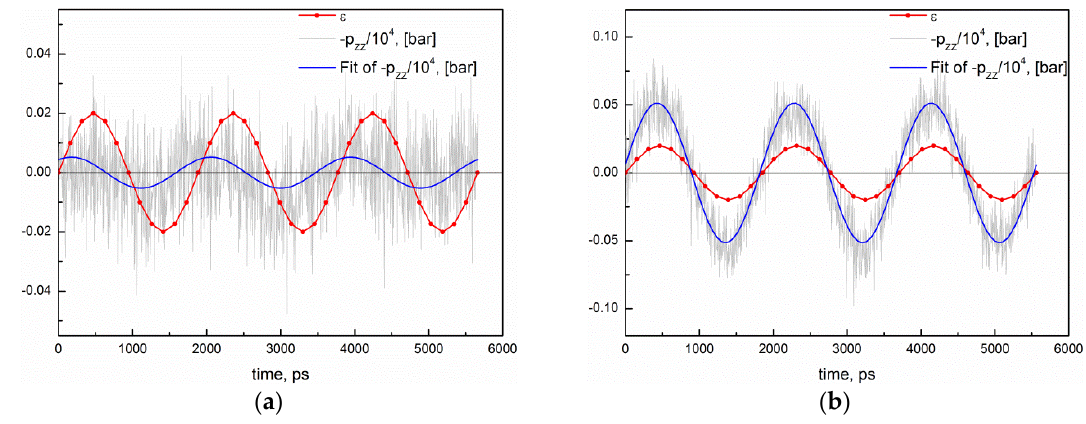
Figure 3. Determination of the storage and loss moduli for systems at T = 450 K: ( a ) The case of a viscous medium, when E” > E’ for the system at the conversion degree, 0.1, (E’ = 0.14 GPa, E” = 0.22 GPa, tan (cid:2012) = 1.56182), and ( b ) the case of elastic medium, when E’ > E” for the system at the conversion degree 0.9 (E’ = 2.55 GPa, E” = 0.31 GPa, tan (cid:2012) = 0.12104). The oscillation frequency varied in the range of 5.3 ∙ 10 8 –5.4 ∙ 10 8 Hz.